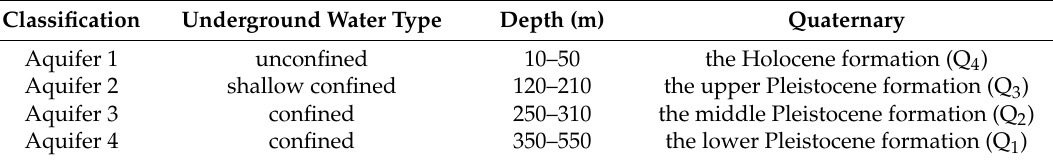
Table 1. The classification of the quaternary aquifers underlying the North China Plain